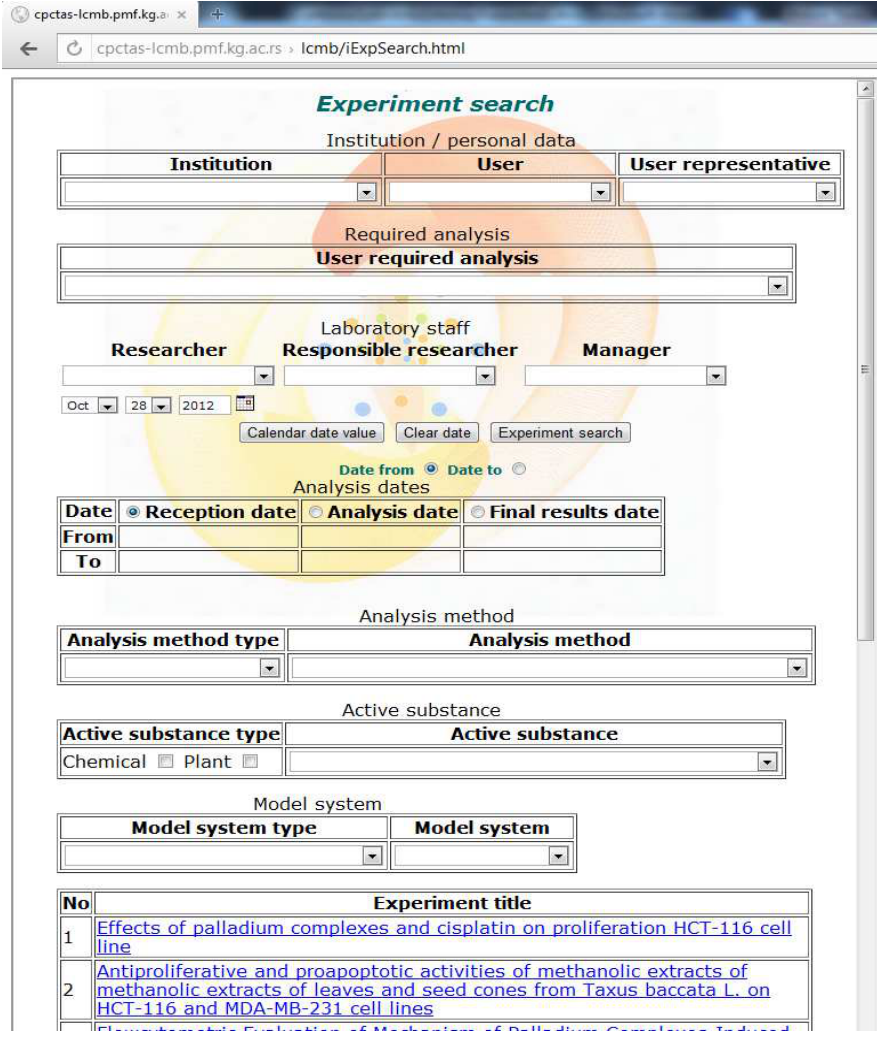
Figure 7. Experiment search web